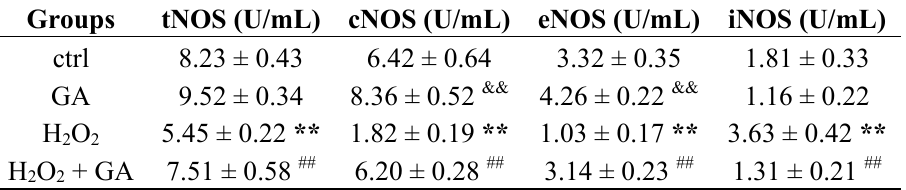
Figure 4. GA promoted the survival of RGC-5 cells by endothelial nitric oxide synthase (eNOS). RGC-5 cells preincubated with various NOS subtype inhibitors were treated with H 2 O 2 (100 µM) in the absence or presence of GA (10 μM). The cell viability was determined by MTT assay. Only L-NIO attenuated significantly the protective effect of GA. && p < 0.01 vs. control group; * p < 0.05, ** p < 0.01 vs. H 2 O 2 -treated group; # p < 0.05 vs. GA + H 2 O 2 treated group ( n = 3). Table 1. Effects of GA, H 2 O 2 and GA/H 2 O 2 on the NOS activities in RGC-5 cells. Groups tNOS (U/mL) cNOS (U/mL) eNOS (U/mL) iNOS